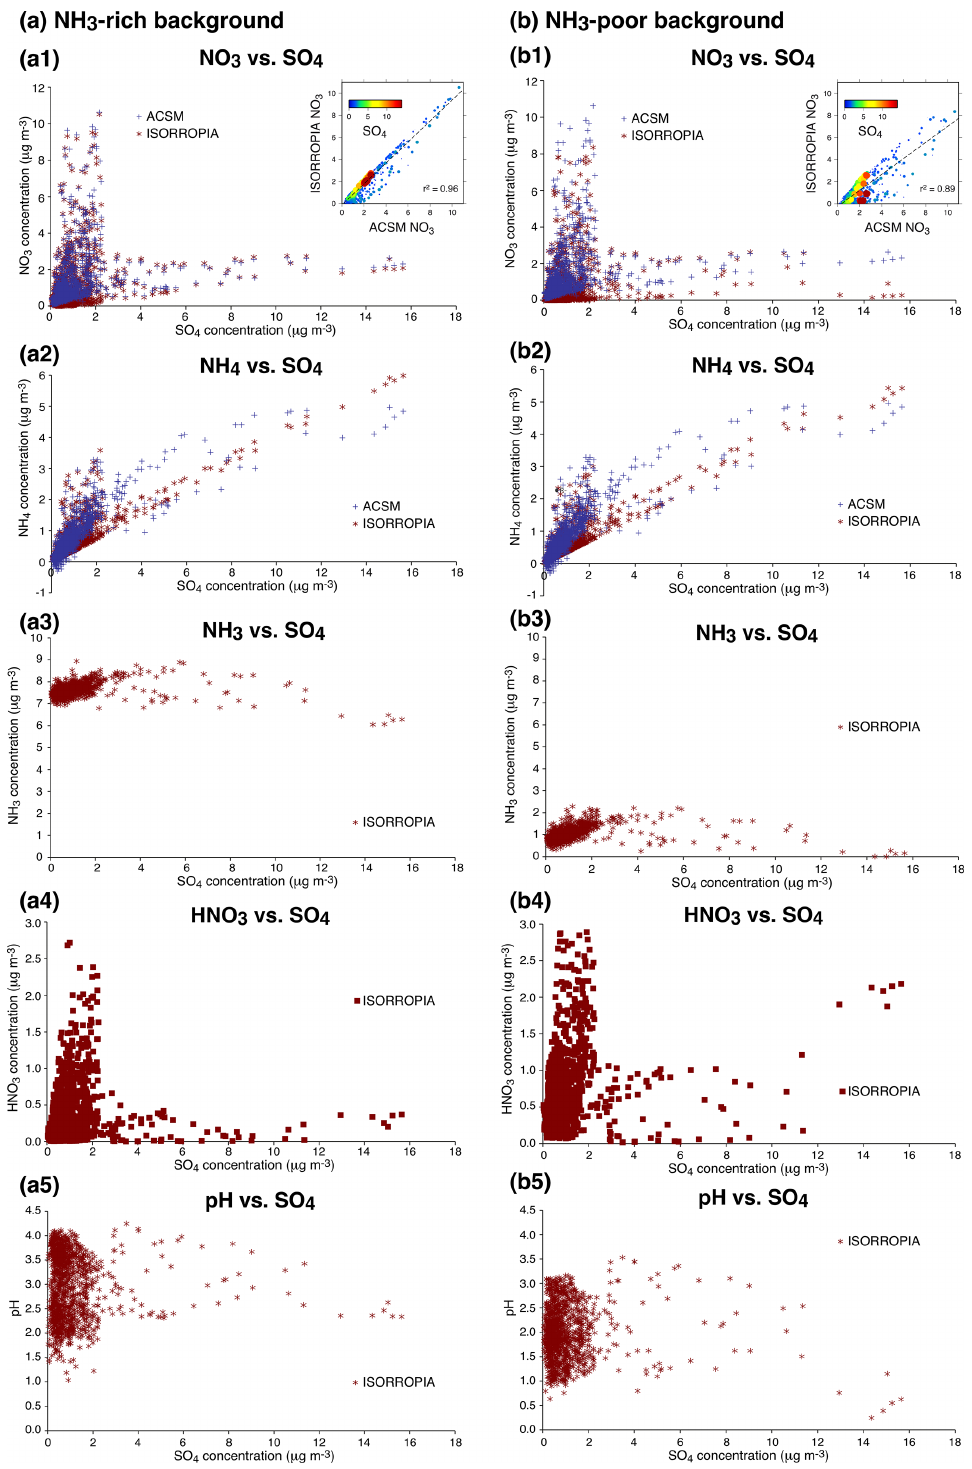
Figure 10. ISORROPIA II thermodynamic model simulations (red) of atmospheric composition (aerosol NO 3 a1, b1 and NH 4 a2, b2 , gas- phase NH 3 a3, b3 and HNO 3 a4, b4 ) as well as pH (a5, b5) vs. SO 4 mass concentration at SIRTA in September–October 2014 considering an environment either (a) rich (7.40µgm − 3 ) or (b) poor (0.74µgm − 3 ) in NH 3 . Comparison with ACSM observations of aerosols (blue). Inset in (a1) and (b1) shows ISORROPIA NO 3 vs. ACSM NO 3 coloured with the concentration of sulfate.